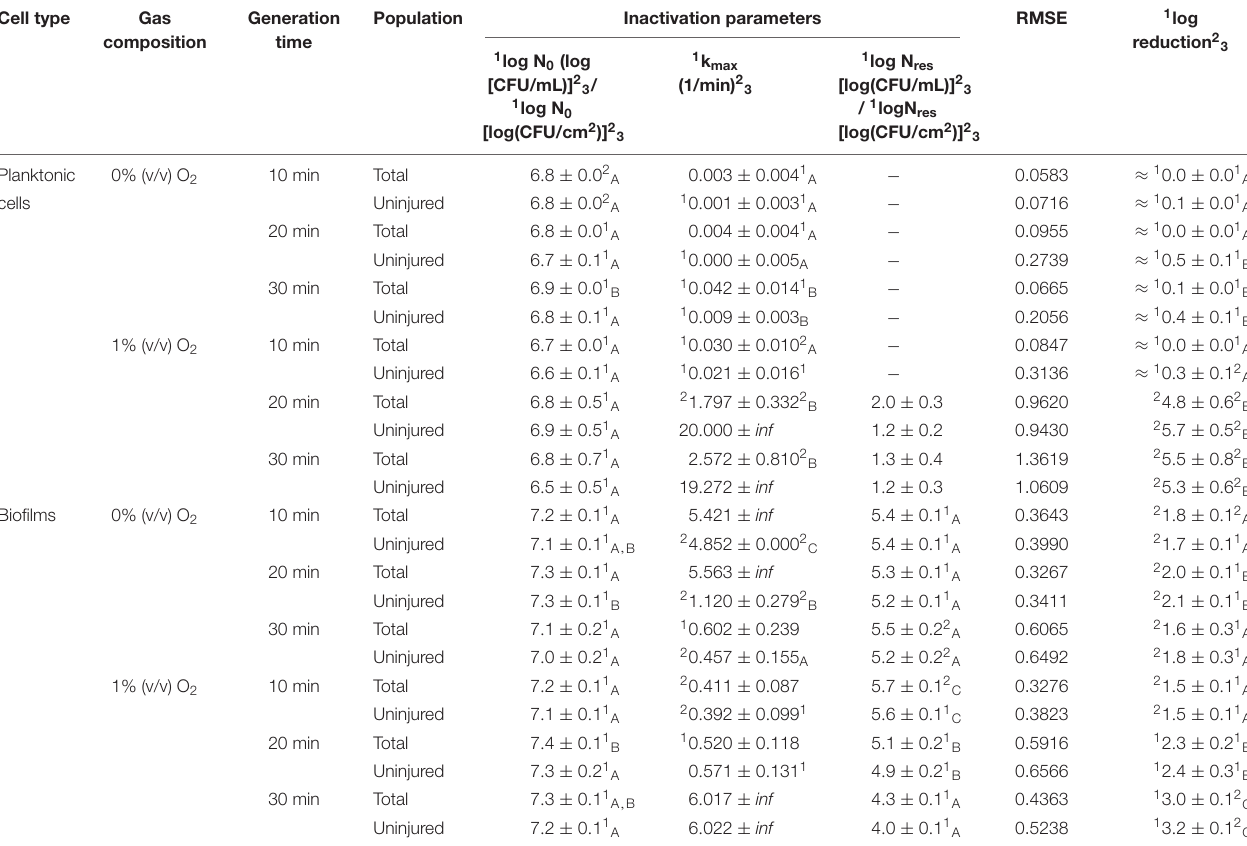
TABLE 2 | Inactivation parameters of Geeraerd et al. (2000) model for L. monocytogenes planktonic cells and biofilms after plasma activated liquid